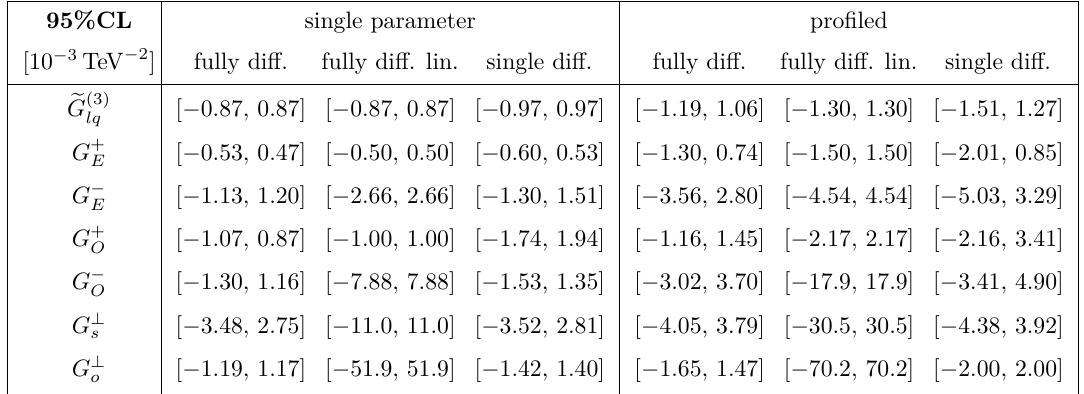
Table 11 . 95% CL projected bounds (in 10 − 3 TeV − 2 units) for the seven parameters e G (3) and G ⊥ at the 14 TeV LHC with L = 300 fb − 1 s,o